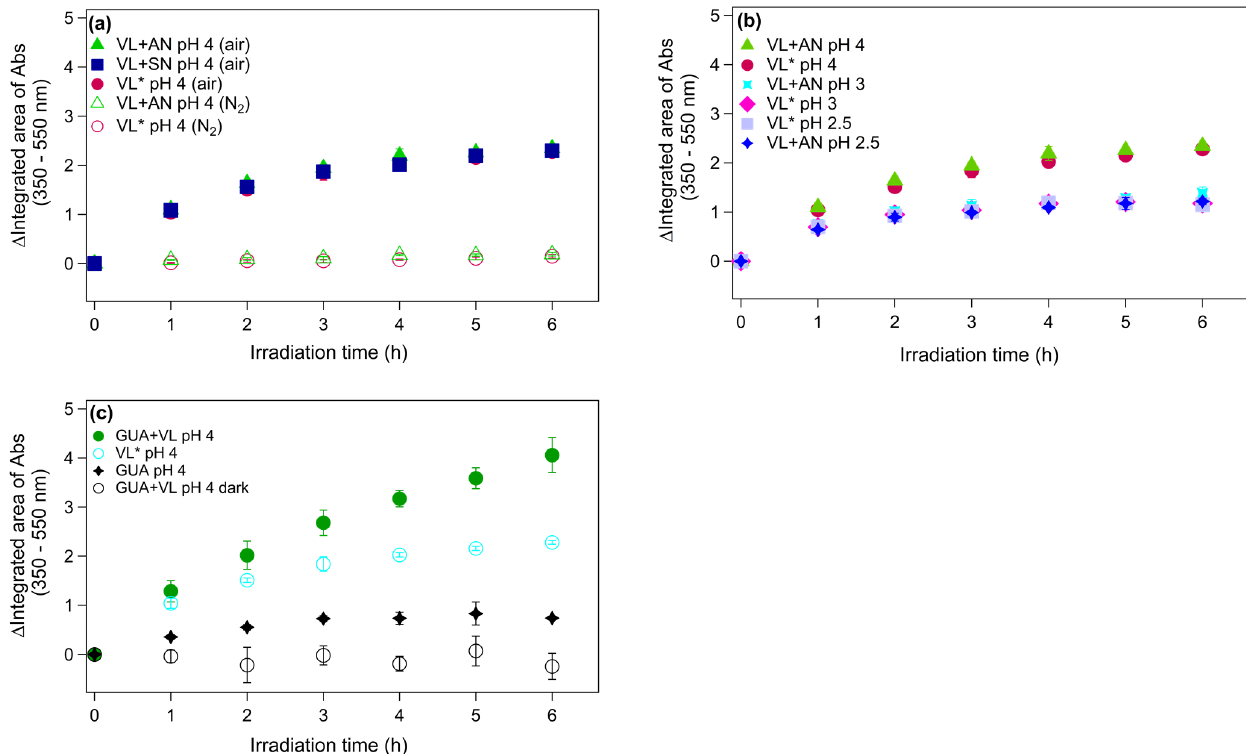
Figure 3. (a–c) Increase in light absorption under different experimental conditions for direct photosensitized oxidation of VL in the absence (VL ∗ ) and presence of ammonium nitrate (VL + AN). (a) VL ∗ and VL + AN at pH 4 under N 2 − (A6 and A8) and air-saturated (A5 and A7) conditions. Direct photosensitized oxidation of VL in the presence of sodium nitrate (VL + SN) at pH 4 under air-saturated conditions (A9). (b) Effect of pH on VL ∗ and VL + AN at pH 2.5 (A1 and A2), 3 (A3 and A4), and 4 (A5 and A7) under air-saturated conditions. (c) Increase in light absorption during direct GUA photodegradation (A13) and the oxidation of GUA via photosensitized reactions of VL (GUA + VL; A14) at pH 4 under air-saturated conditions after 6h of simulated sunlight irradiation. Error bars represent 1 standard deviation; most error bars are smaller than the